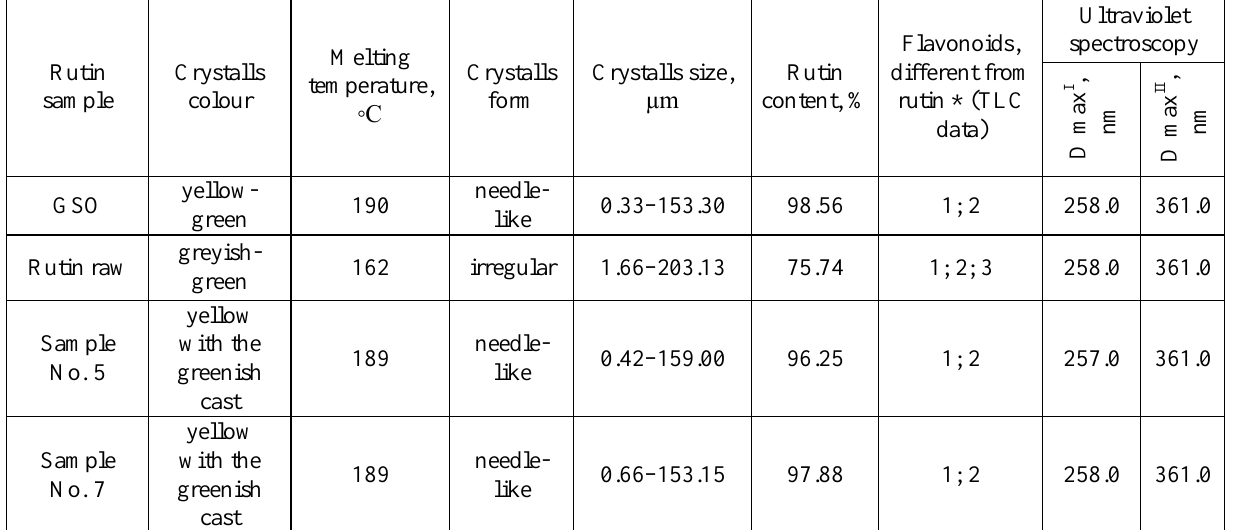
Table 2. Rutin physical and chemical parameters